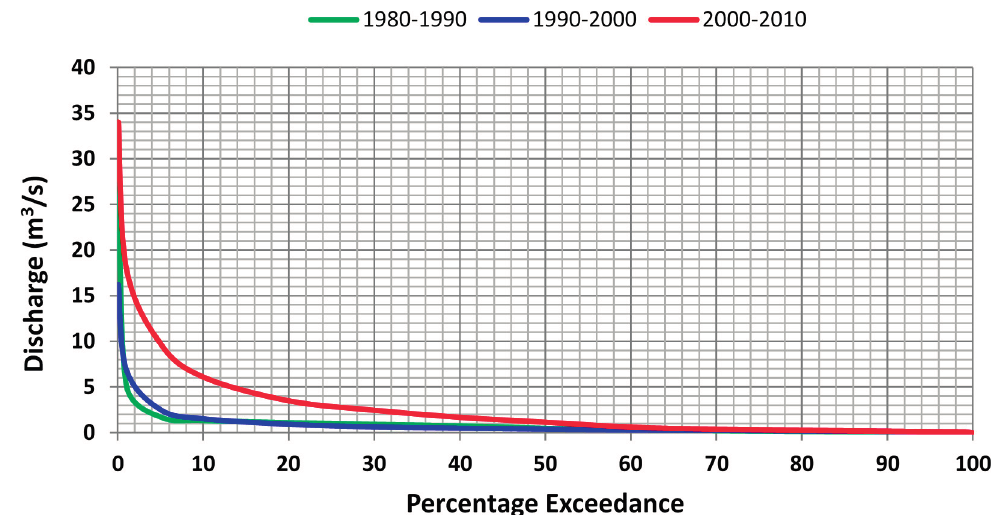
Figure 10. Flow duration curves in the Marimba catchment for the periods 1980–1990, 1990–2000 and 2000–2010.